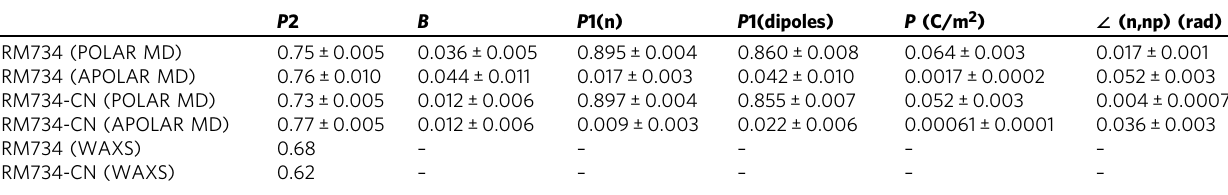
Table 1 Calculated order parameters.